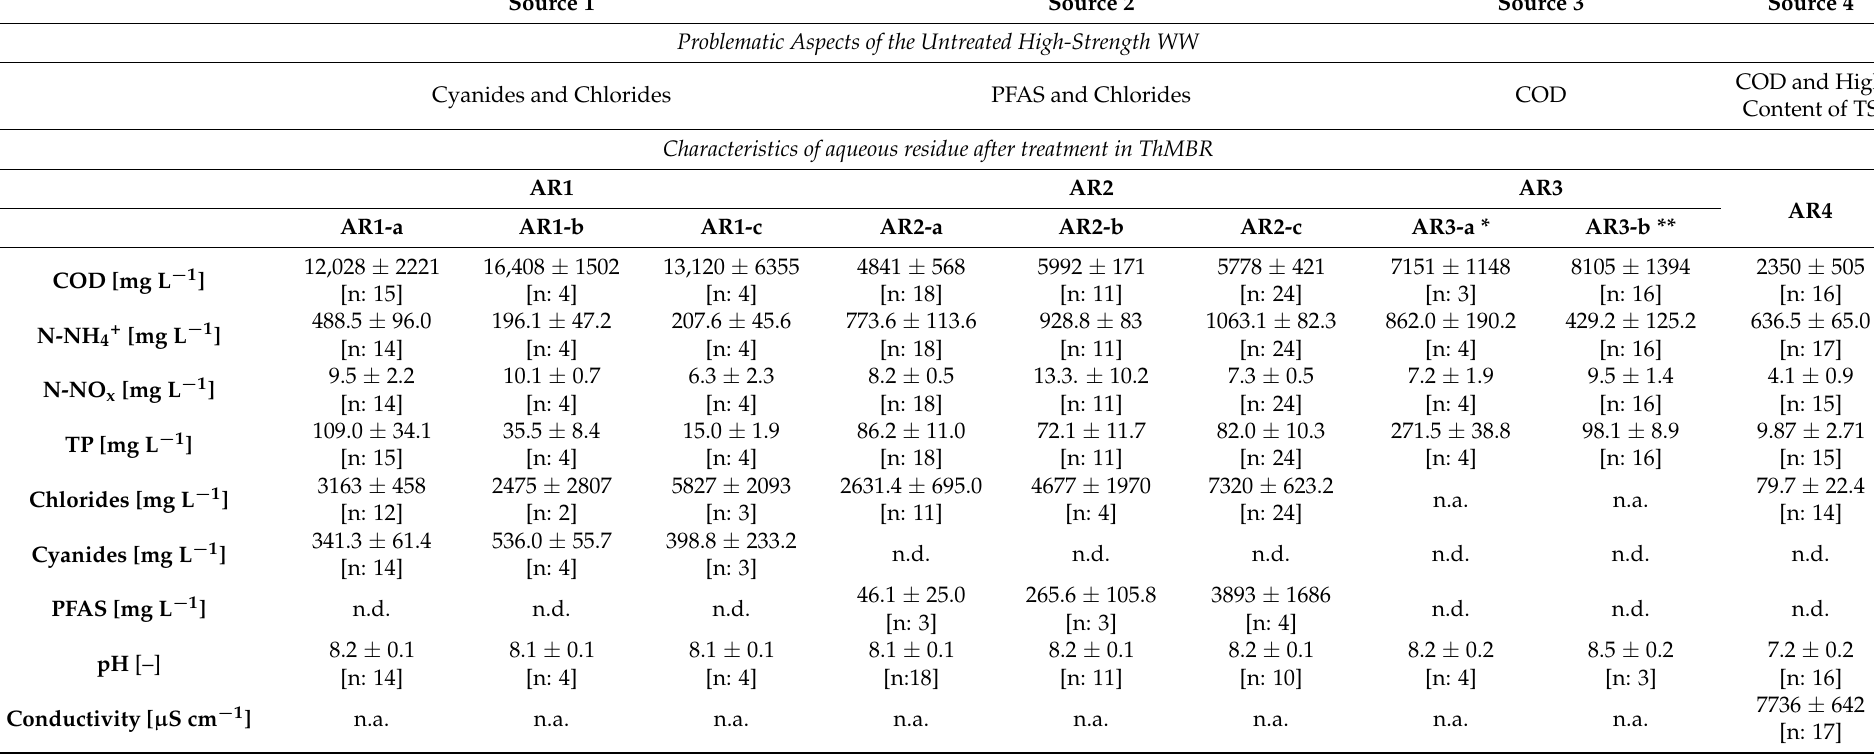
Table 2. Summary of chemical and physicochemical characteristics of AR extracted from the pilot-scale